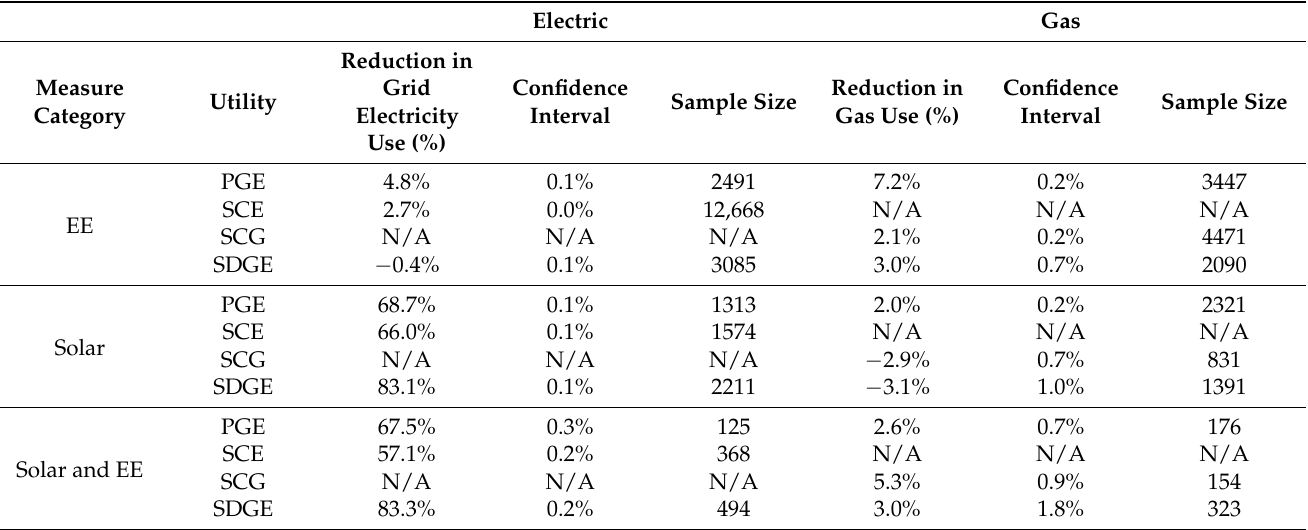
Table 3. Average R-PACE project impacts by California